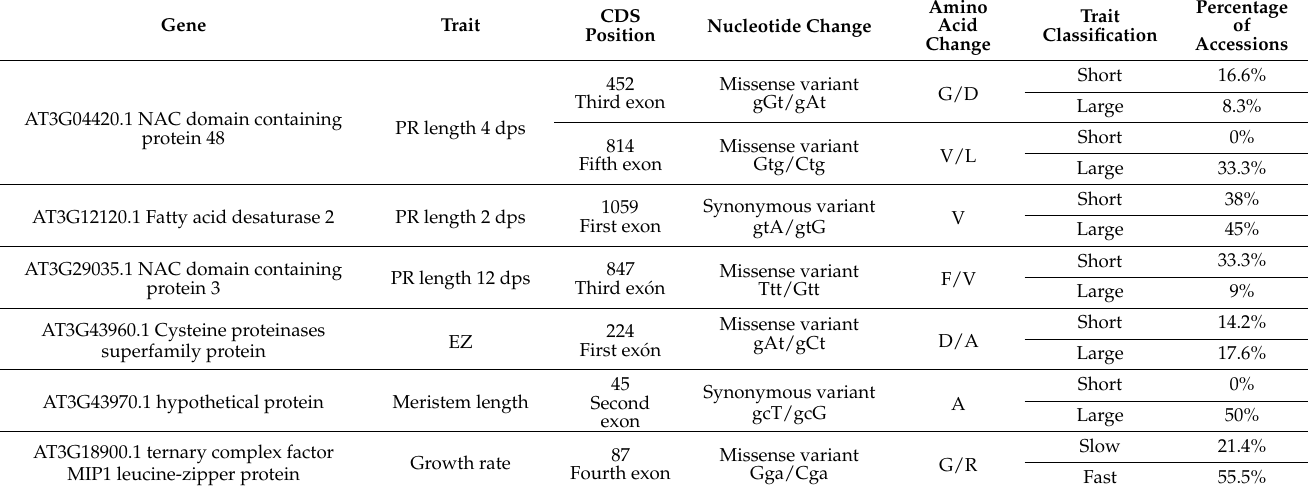
Table 2. SNPs found in the six candidate genes obtained by GWAS in contrasting